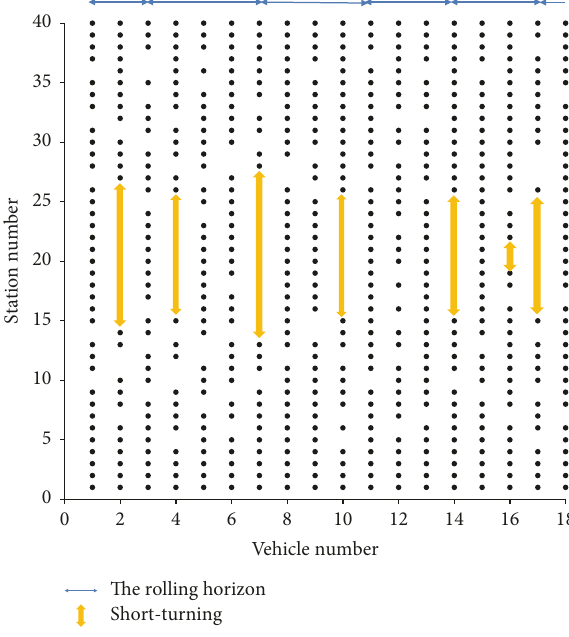
Figure 4: Passenger load between consecutive stations.